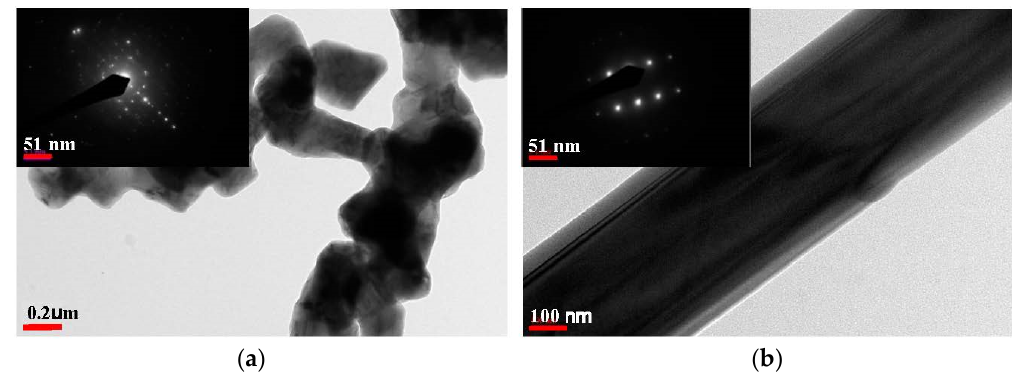
Figure 5. TEM images of coated materials on AlN layers with insert SEAD patterns: ( a ) T15ANF and ( b ) T17ANF.